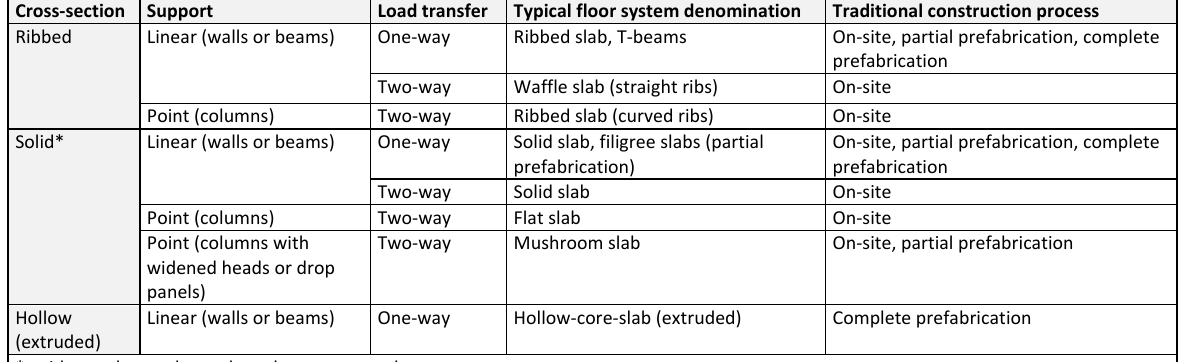
Table 2. Overview of reinforced concrete floor systems.